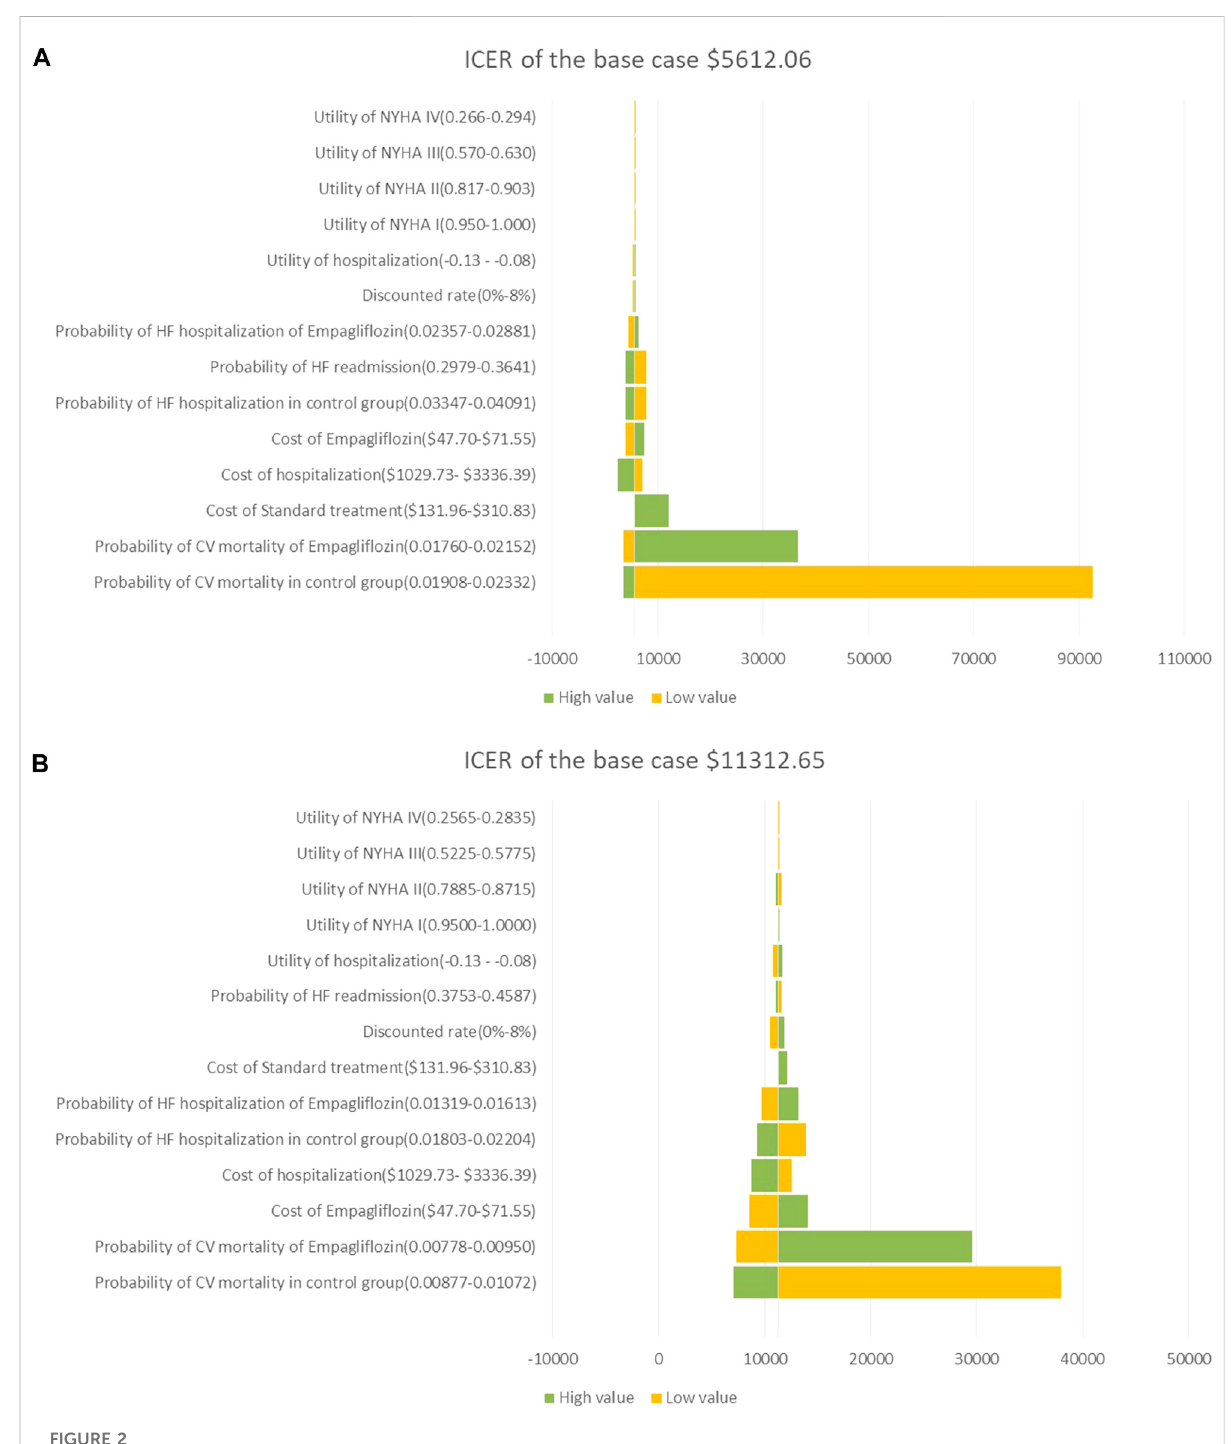
FIGURE 2 (A) Tornado diagram showing the univariate sensitivity analysis of the Markov model simulation in HFrEF population. (B) Tornado diagram showing the univariate sensitivity analysis of the Markov model simulation in HFpEF